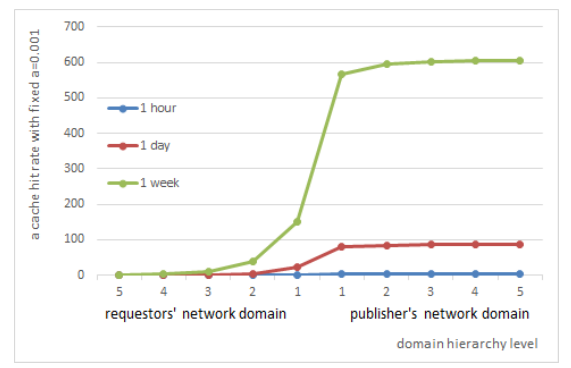
Figure 3. The cache hit rate of NDN node comparison.